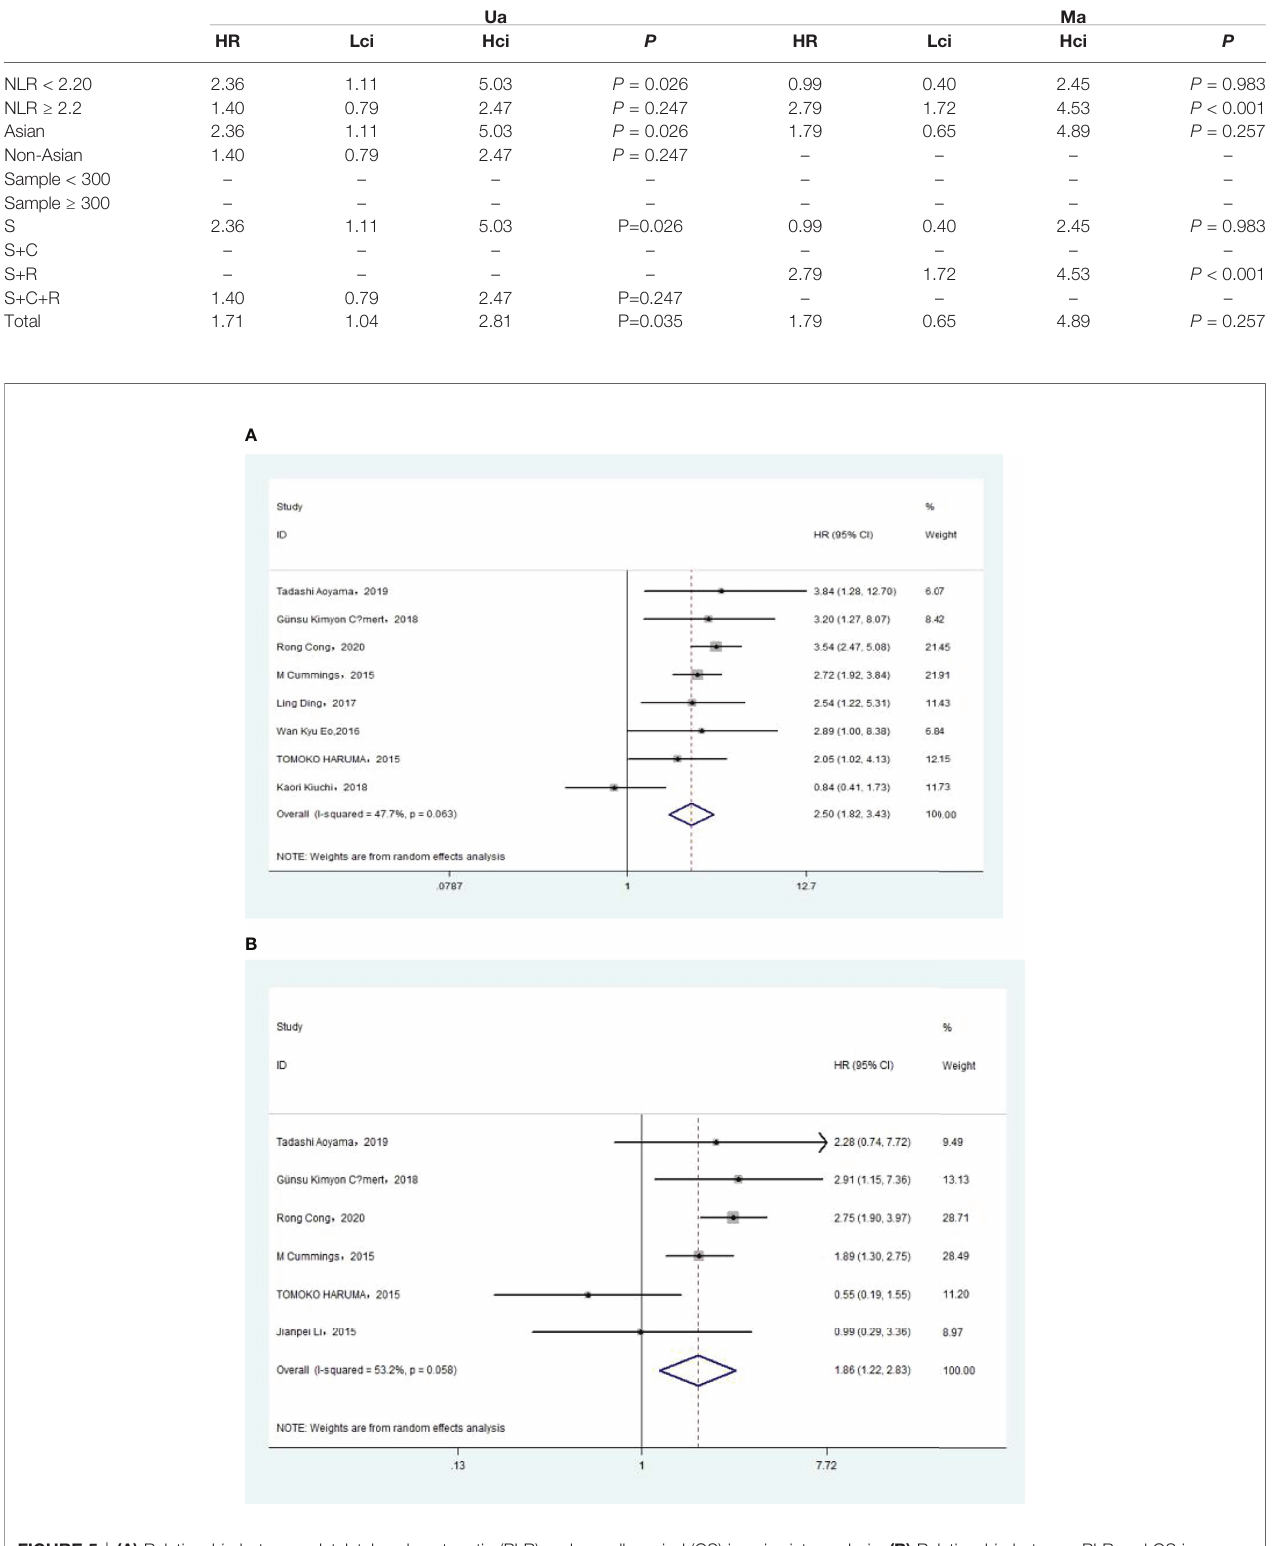
FIGURE 5 | (A) Relationship between platelet – lymphocyte ratio (PLR) and overall survival (OS) in univariate analysis. (B) Relationship between PLR and OS in multivariate